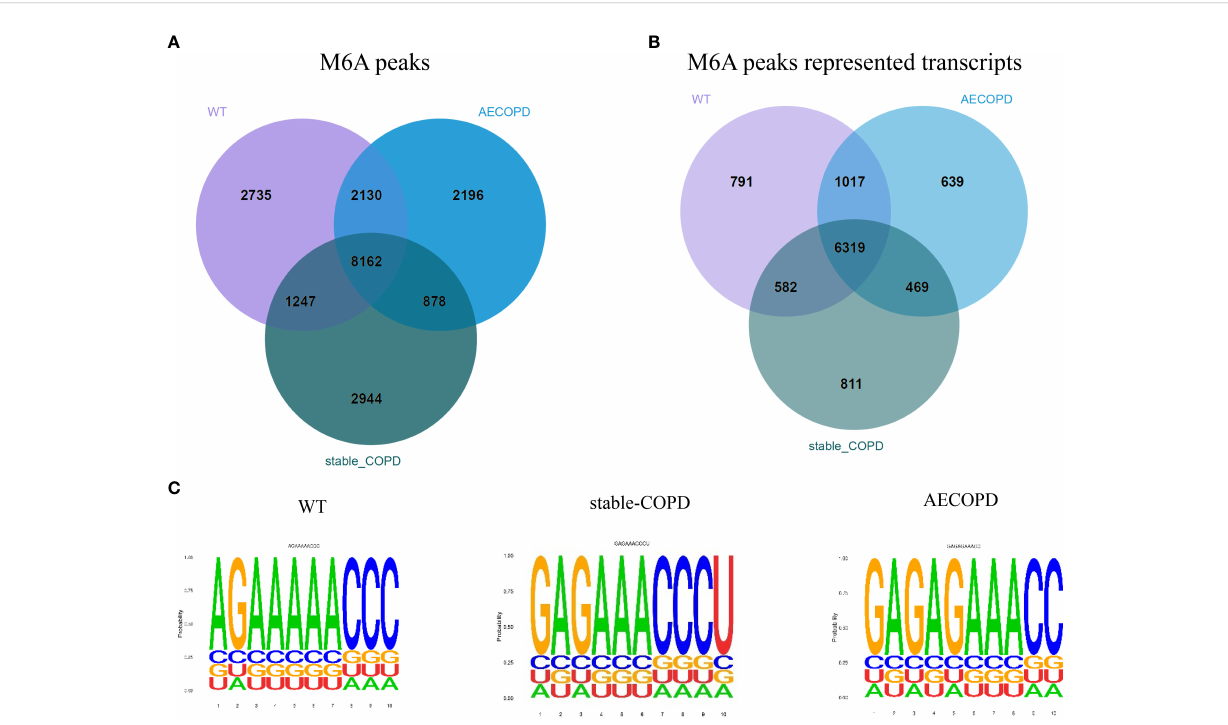
FIGURE 4 m6A-Seq of the transcriptome width reveals the overall m6A modi fi cation mode in the COPD group: (A) Number of common and speci fi c m6A peaks in the control, stable COPD, and AECOPD group; (B) Venn diagram of transcript m6A peaks for the three groups; (C) motifs enriched from m6A peaks identi fi ed from the control, stable COPD, and AECOPD